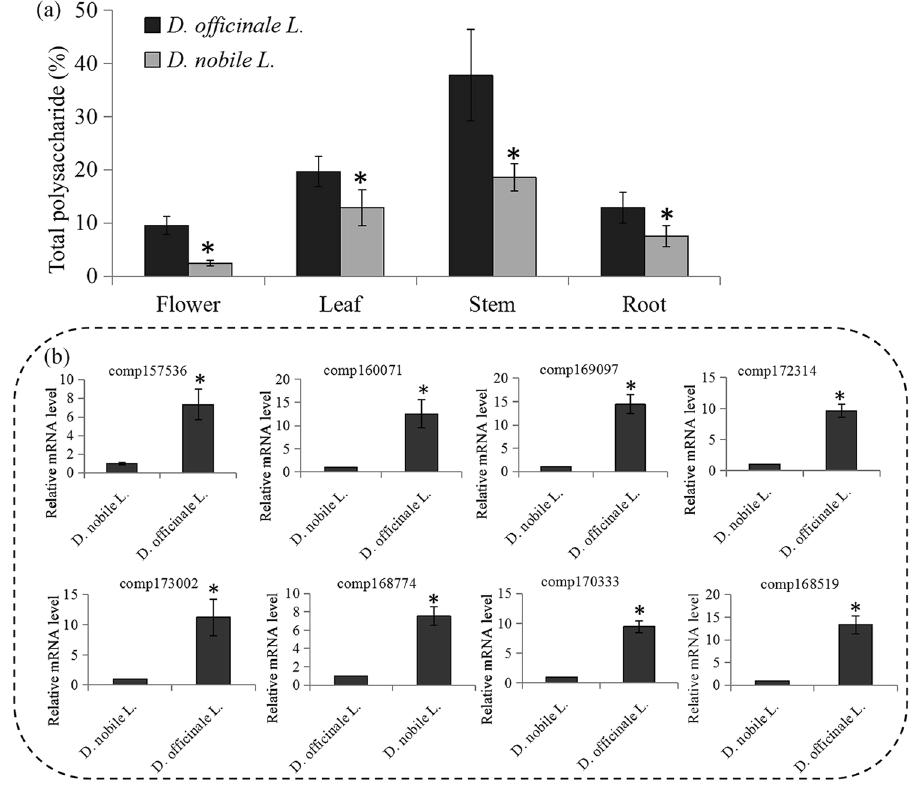
Figure 6. Polysaccharide contents determination and expression analysis of key polysaccharide biosynthetic genes in two different dendrobium species. ( a ) The polysaccharide contents were measured in four organs of two different dendrobium species ( D. nobile L. and D. officinale L.). The significantly changes in polysaccharide contents between D. nobile L. and D. officinale L. were indicated by “ * ”. ( b ) The related expression levels of eight D. officinale L. highly expressed genes. The significantly changes in expression levels of polysaccharide genes between D. nobile L. and D. officinale L. were indicated by “ *